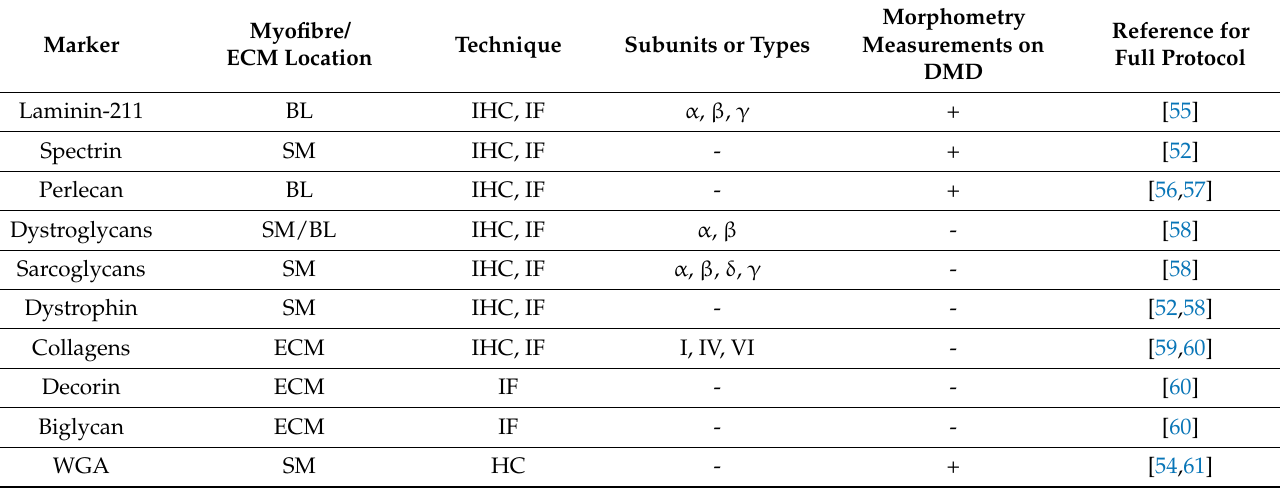
Table 1. Muscle fibre peripheral